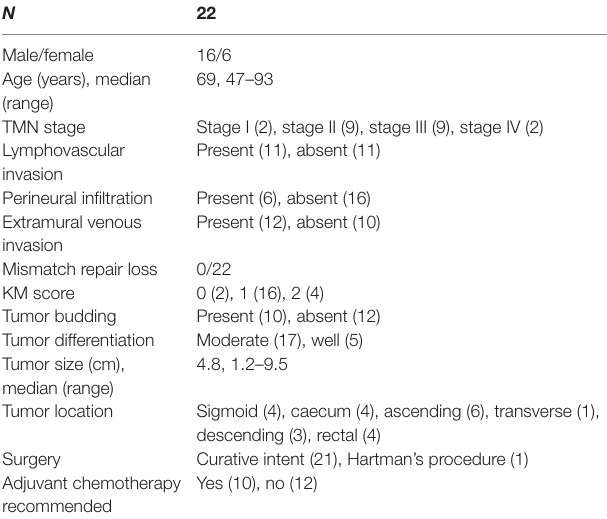
TaBle 1 | Patient